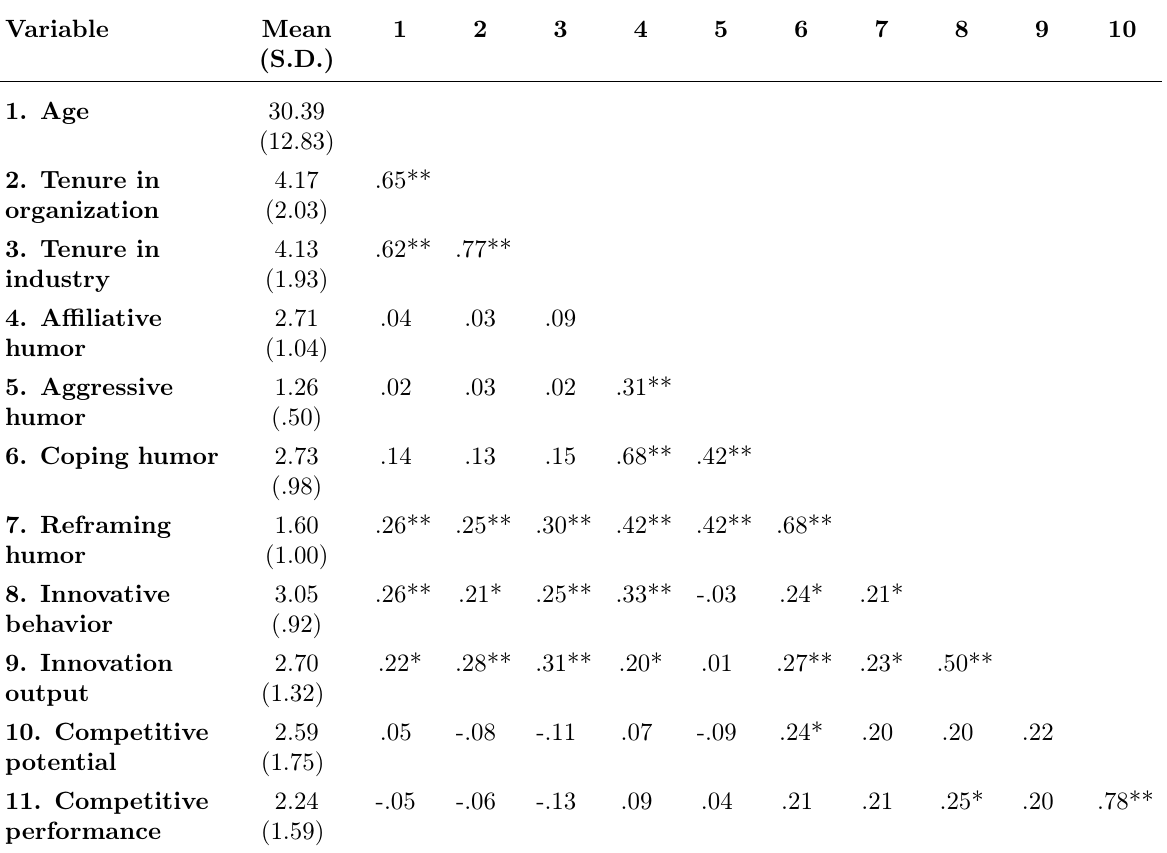
Table 2. Correlations for humor use with external actors (outgroup).